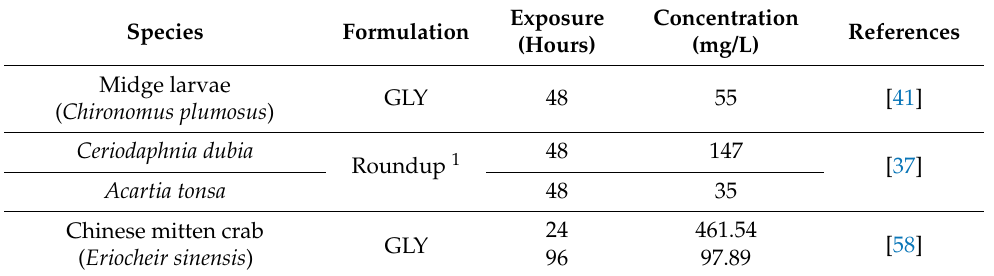
Table 3. Acute toxicity values (LC50) of glyphosate and its commercial products on invertebrate species. Species Formulation